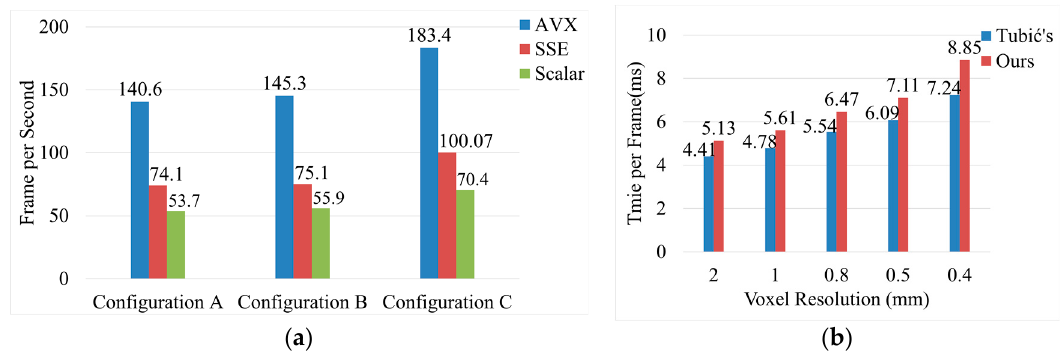
Figure 19. Time efficiency comparison; ( a ) frame rate comparison of real-time reconstruction algorithms on three different hardware configurations in Table 2; the blue bars represent the algorithm implemented with Advanced Vector Extension Instruction Set (AVX) [68], red bars represent Streaming SIMD Extensions Set (SSE) [69], and the green bars represent the version with no instruction sets; ( b ) performance comparison with Tubi ć et al. [6].